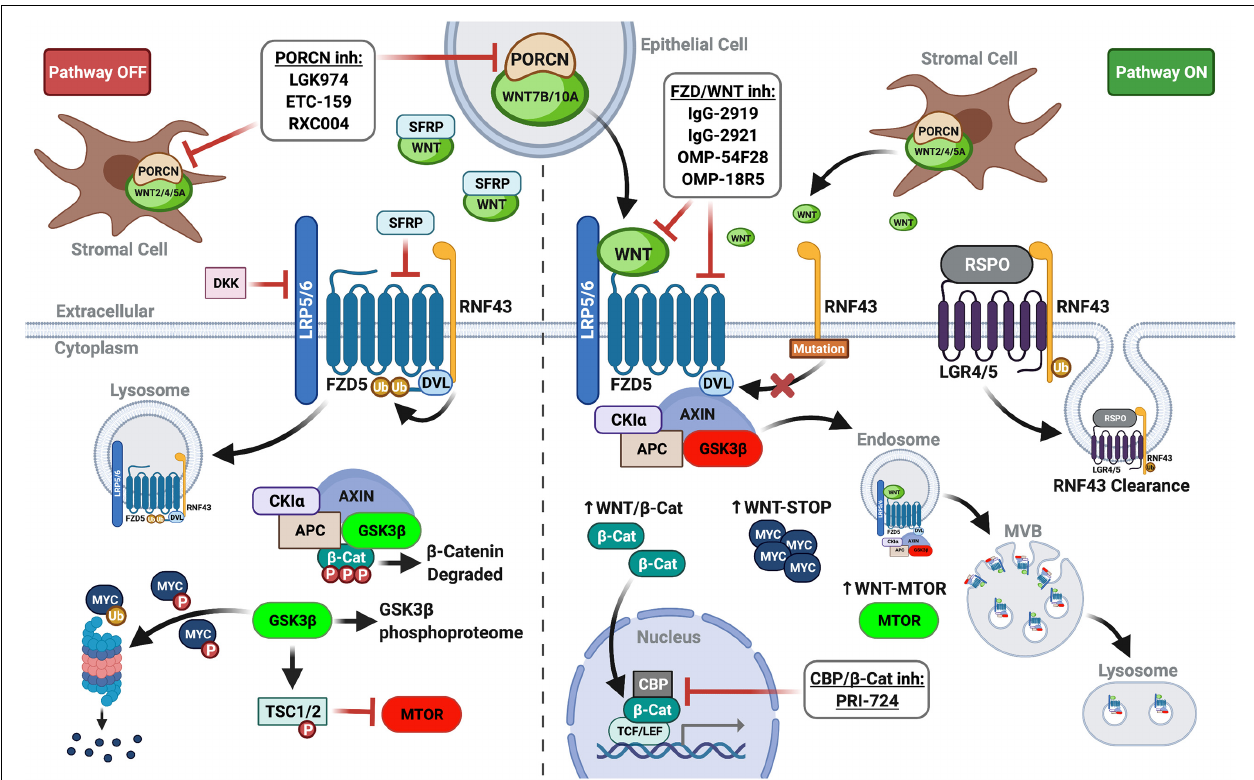
FIGURE 1 | WNT plasma membrane signaling in PDAC. (Left panel) In the absence of FZD-LRP5/6 signaling (lack of WNT ligand and/or inhibition by extracellular DKKs or SFRPs), β -catenin is targeted for degradation. GSK3 β activity also impinges other signaling pathways and controls ubiquitin-mediated degradation of proteins. (Right panel) Augmented by RNF43 mutations or RSPO inhibition of RNF43, WNT ligand signaling re-localizes and inactivates the destruction complex to stabilize β -catenin, increasing its nuclear translocation and co-transcriptional activity. GSK3 β sequestration in multivesicular bodies (MVB) prevents substrate phosphorylation, promoting WNT-STOP, WNT-MTOR, and further pathway crosstalk (i.e., de-repression of MAPK/ERK). Thus, upstream WNT pathway inhibitors (PORCN inhibitors, FZD receptor blockers, and FZD decoy receptors) mediate additional actions divergent from downstream WNT pathway inhibitors targeting β -catenin in the nucleus (i.e., PRI-724). Created with BioRender.com.